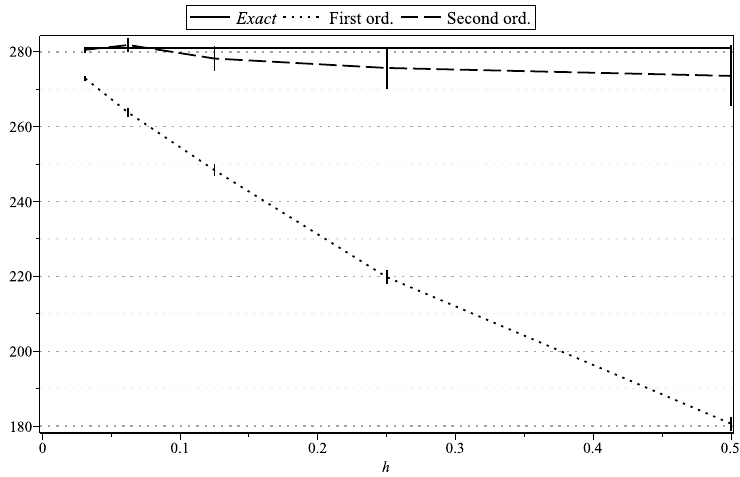
) 4 as functions of h : σ = 1.5, x 1